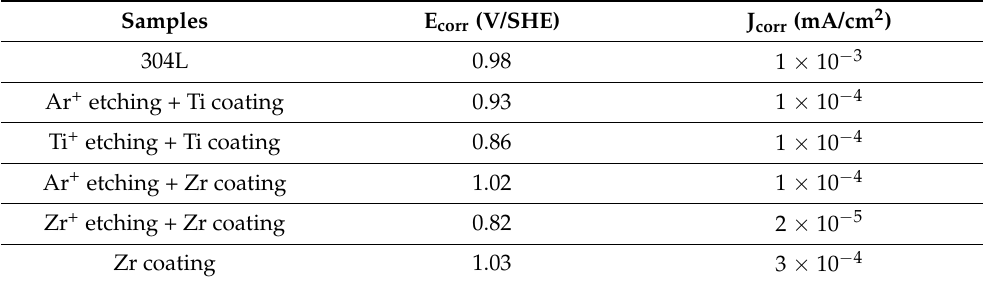
Figure 9. Potentiodynamic polarization curves of raw 304L and etched and metallic bond coat deposited samples in a nitric acid solution at boiling temperature after 6 h of immersion. Black: initial 304L; light green: Ar + etching + Ti coating; red: Ar + etching + Zr coating. Light blue: Ti + etching + Ti coating; deep blue: Zr + etching + Zr coating; grey: Zr coating. Table 3. Corrosion potential (E corr ) and current density (J corr ) values after 6 h of immersion in a nitric acid solution at boiling